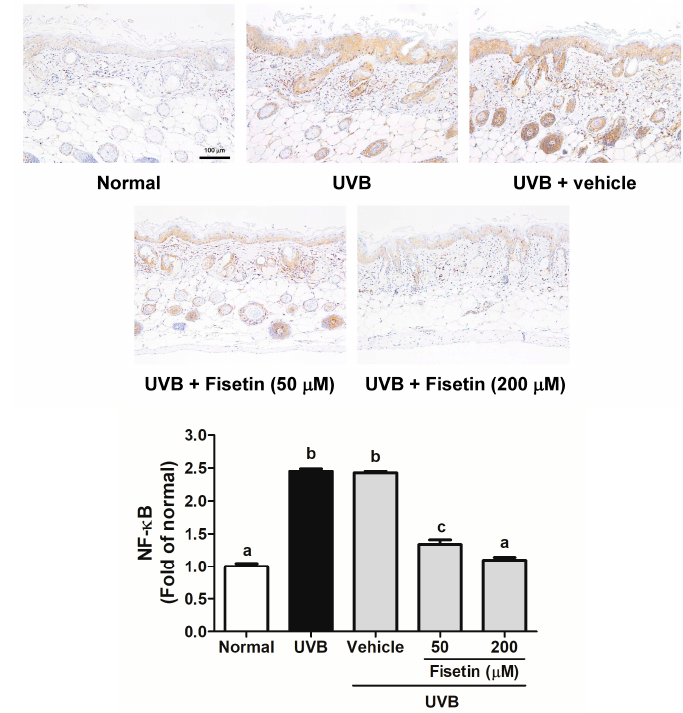
Figure 10. Immunohistochemical staining of IL-6 expression in the epidermis of the mouse skin slices. Fisetin inhibits UVB-induced IL-6 overexpression (200×). a–e: Values not followed by a common letter are significantly different ( p < 0.05).